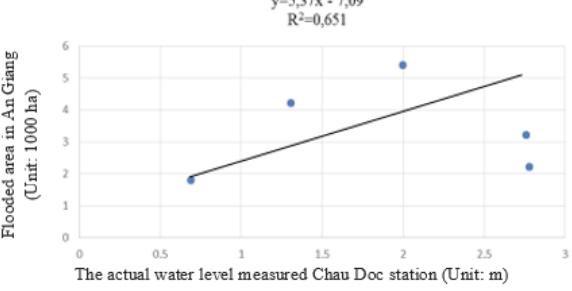
Figure 5: Correlation coefficients between the flooded area and hydrological